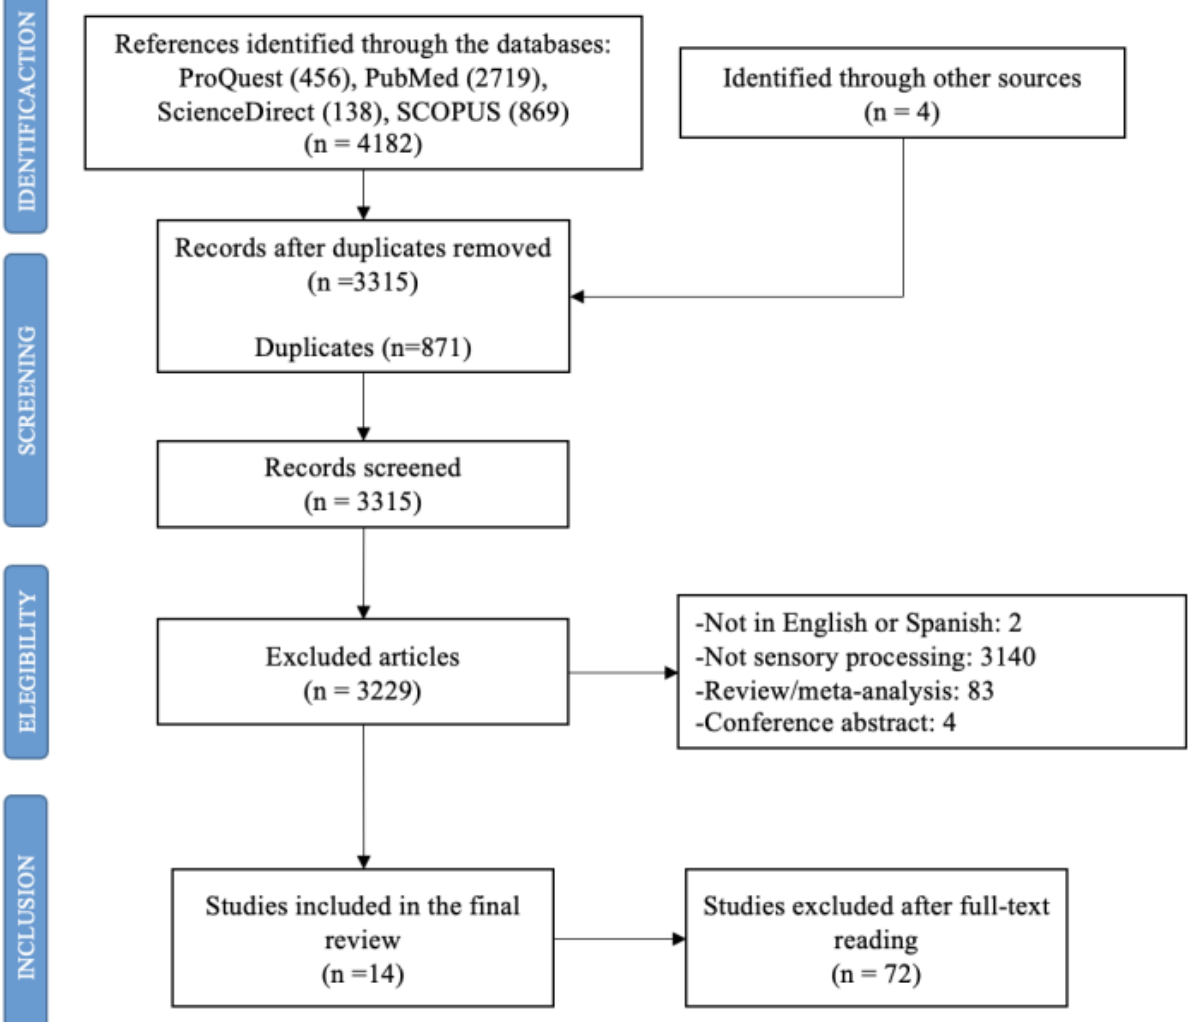
Figure 1. Flow diagram of study selection process.